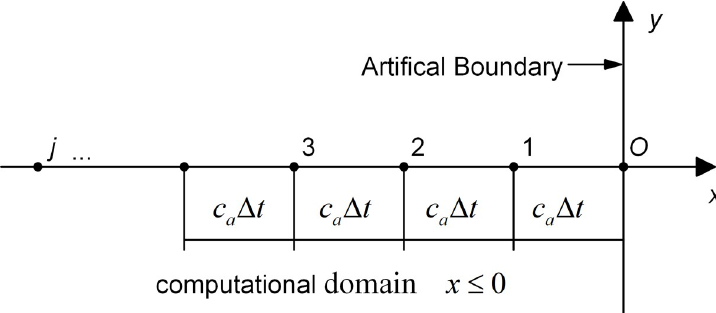
Fig 1. Schematic diagram of the artificial boundary node o and MTF computational